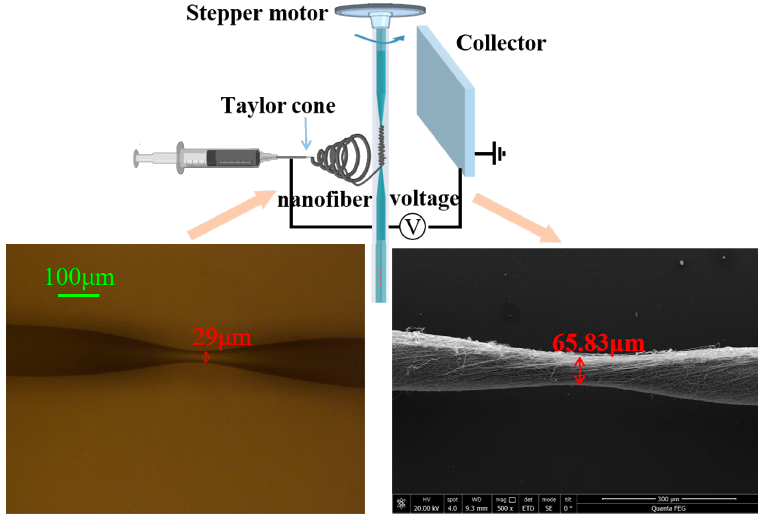
Figure 5. Schematic diagram of electrospinning process, the tapered MMF and the tapered MMF with PVA/CNTs composite nanofiber film.